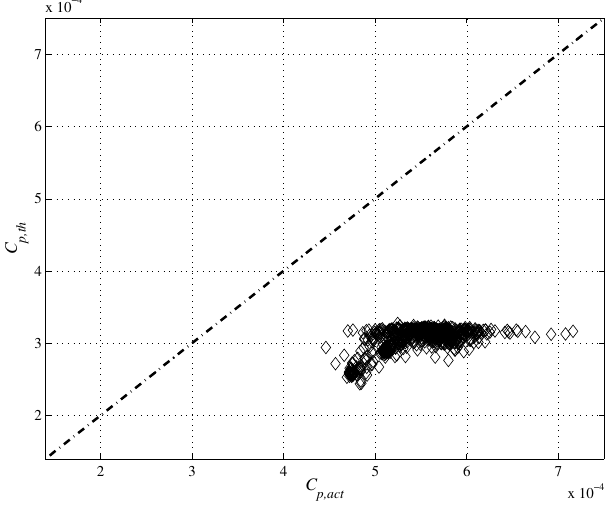
Figure 6. Dimensionless streamflow power, C p , th vs. dimension- less input power, C p , act . The dashed line is the 45 ◦ line.